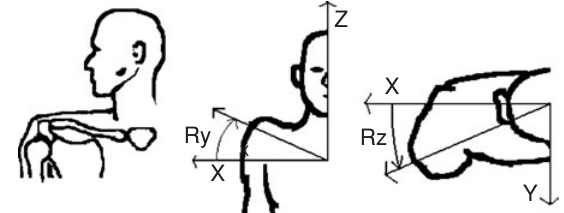
Figure 6 Shoulder movement. Table 2 Correlation coefficients for flex/ext and